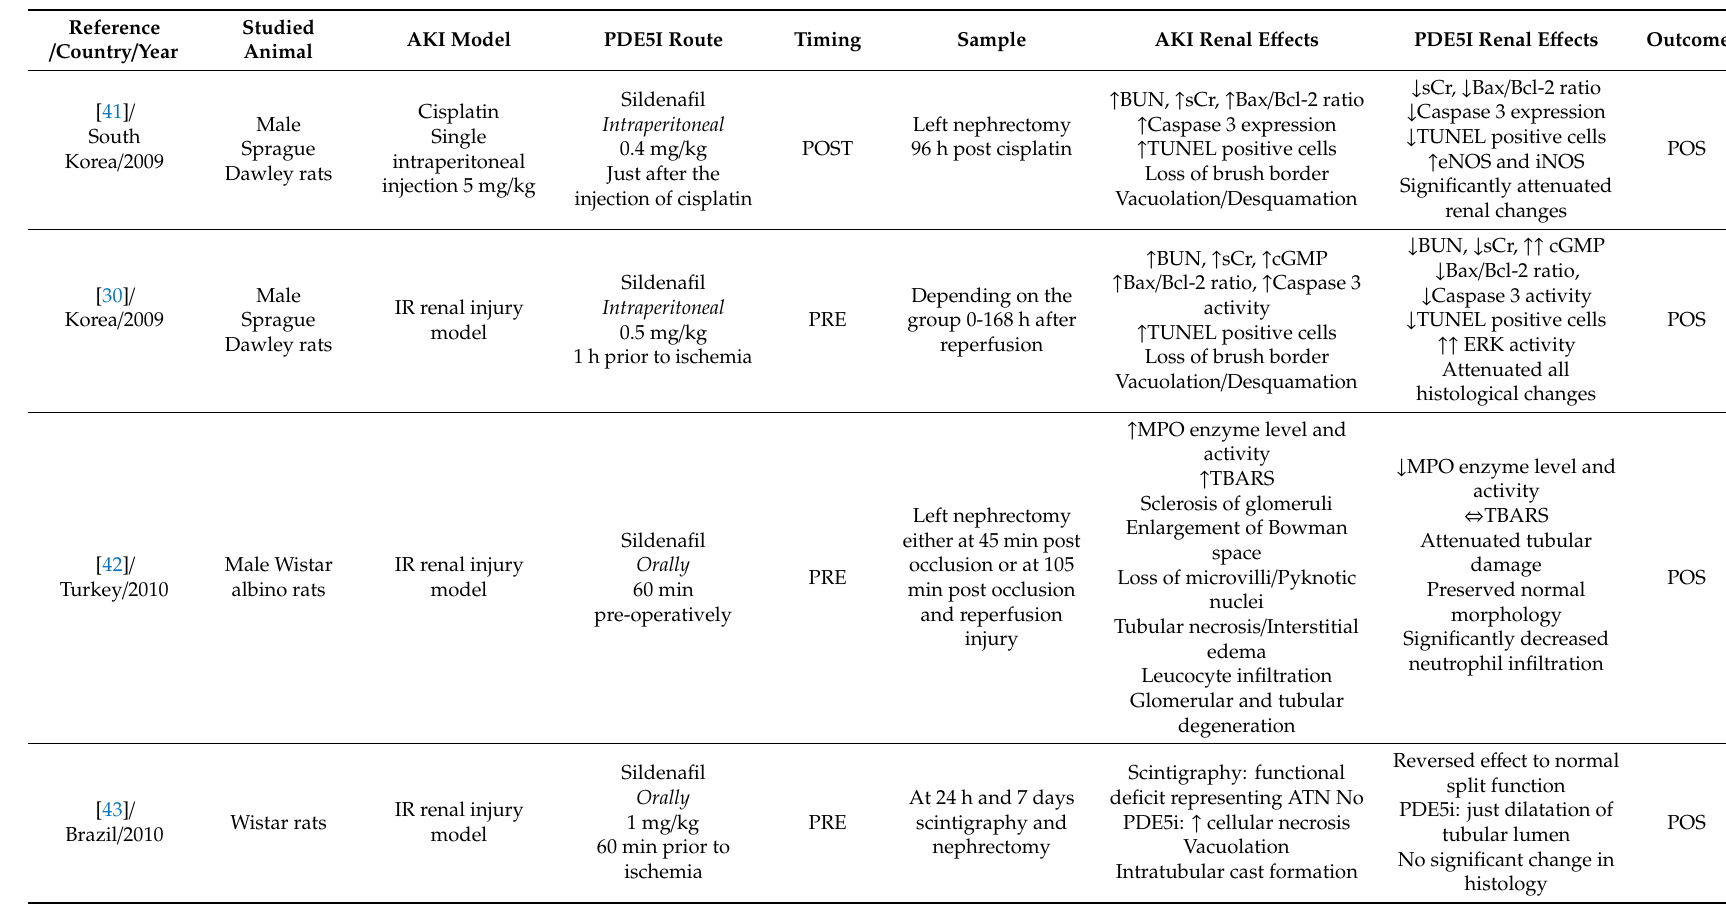
Table 2. Animal studies evaluating the potential reno-protective e ff ects of